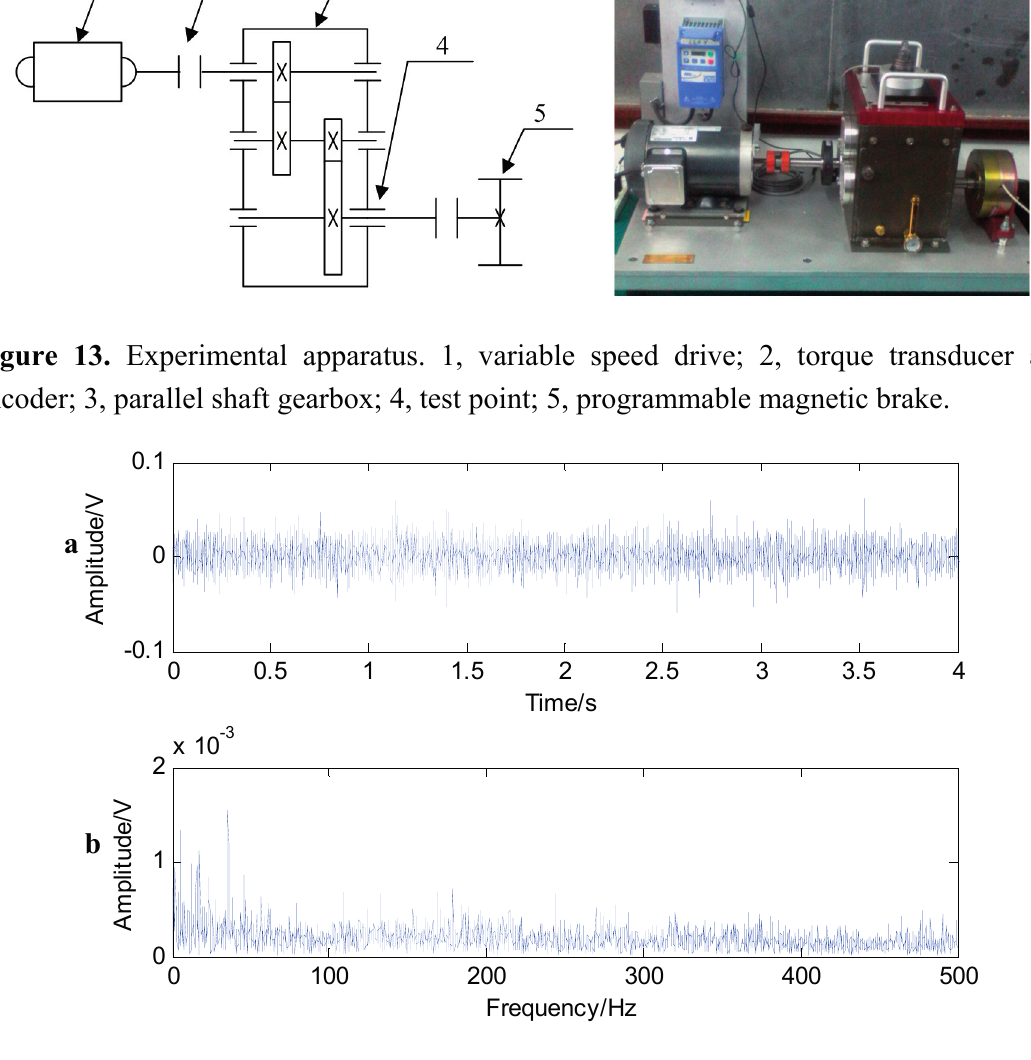
Figure 14. The time waveform of the original signal with an outer race defect ( a ); and the envelop spectrum of the original signal ( b